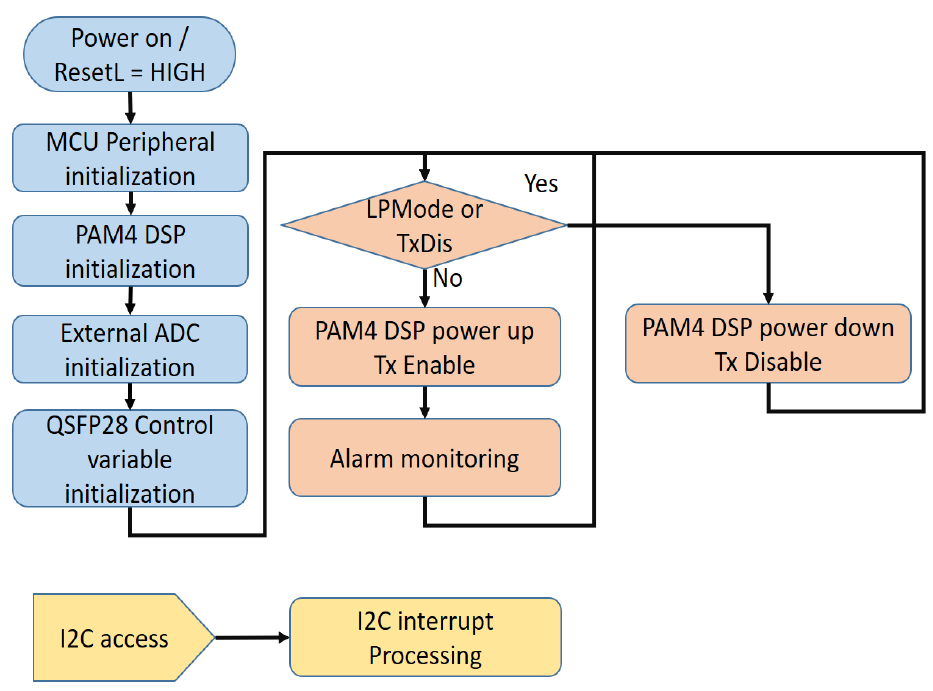
Figure 7. QSFP28 firmware sequence diagram for initialization and